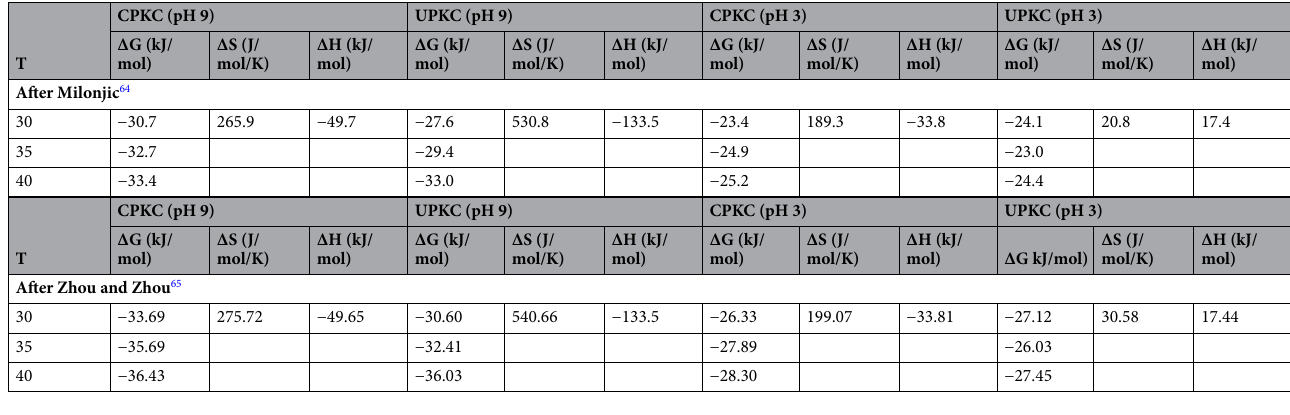
Table 3. Thermodynamic parameters computed according to Zhou and Zhou 68 and Milonjic 67 .